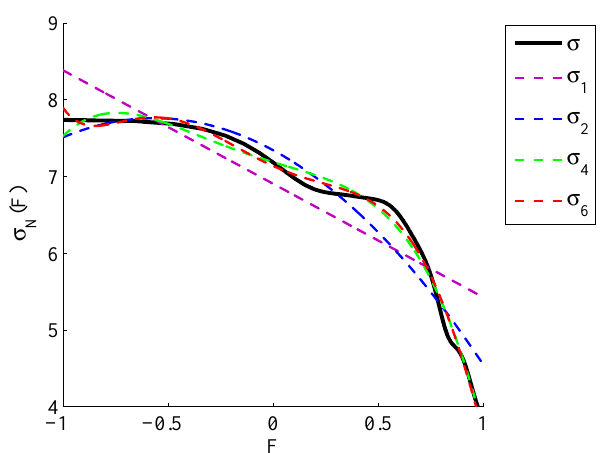
Fig. 2. An example of σ(F) dependence and its approximation σ N (F) with Eq. (2). The experimental curve is shown with a solid black line, and the fitting curves are given with dashed lines. The approximation orders are given with at the